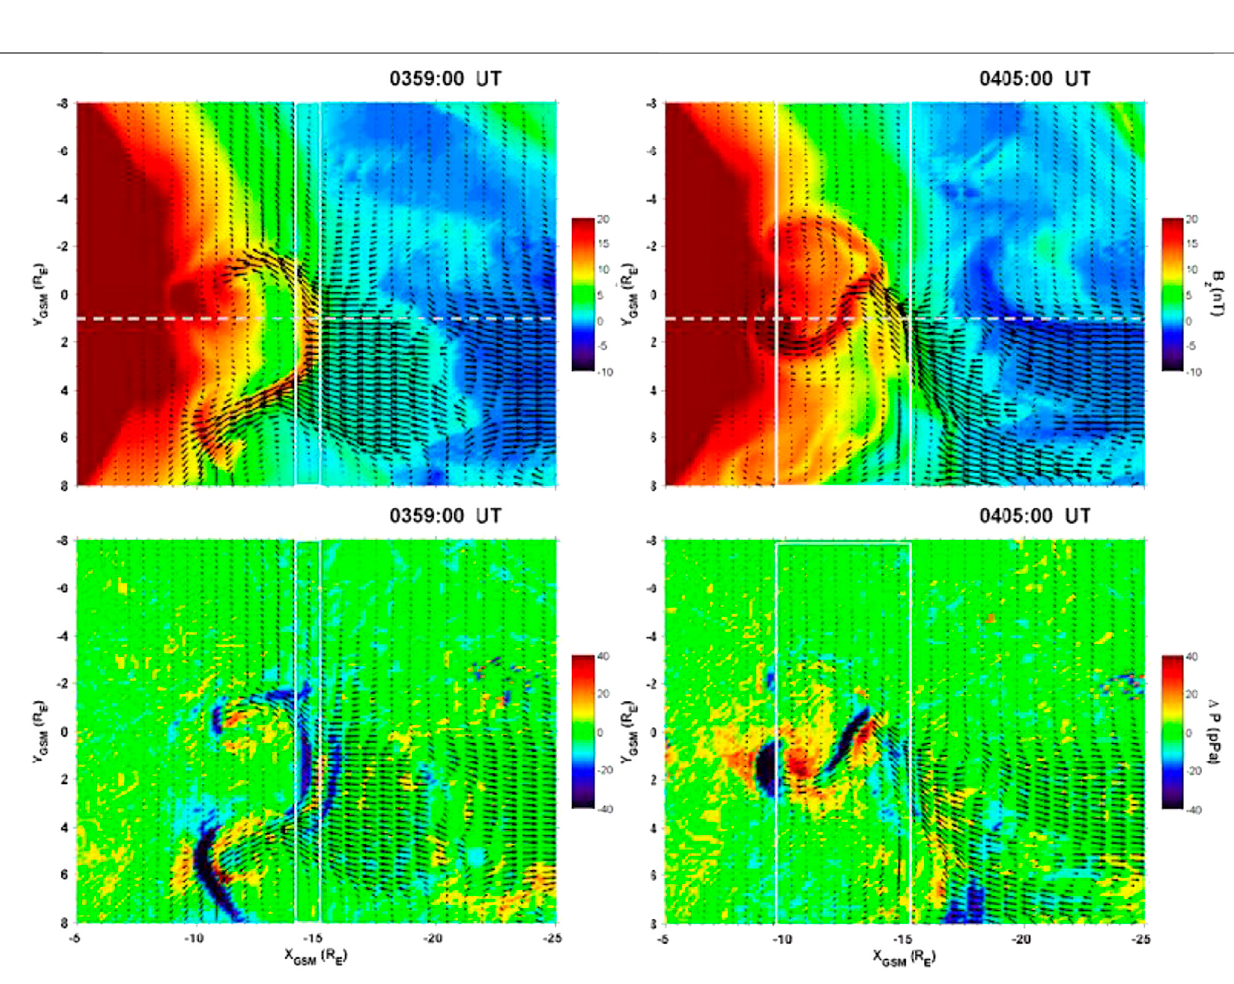
Frontiers in Astronomy and Space Sciences |